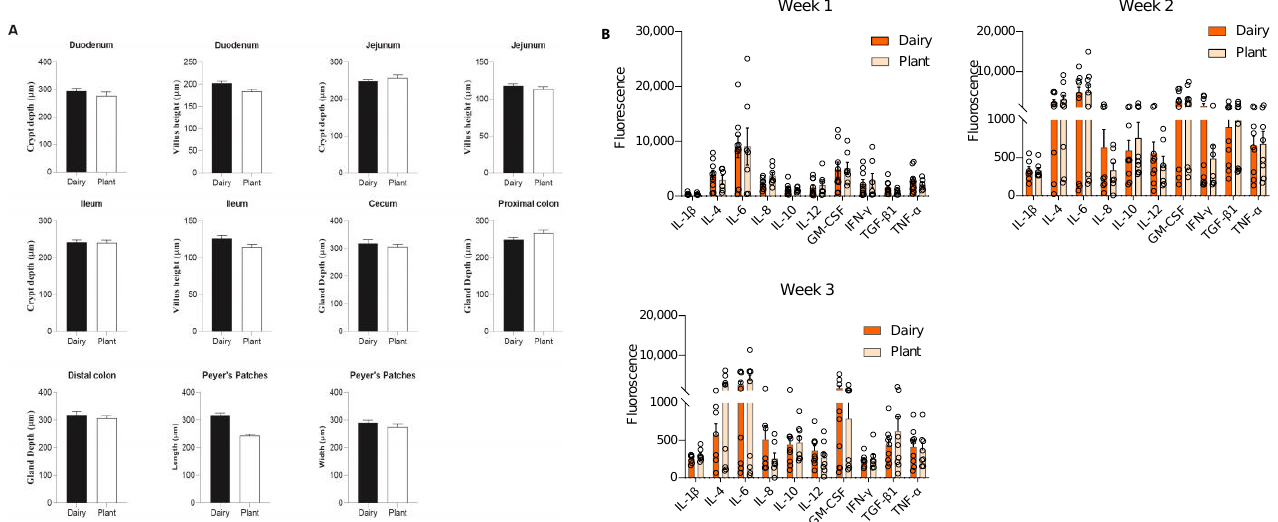
Figure 6. Histomorphometric analyses and plasma cytokines levels of piglets fed a dairy-based formula or a plant-based formula. ( A ) Histomorphometric parameters of duodenum, jejunum, ileum, cecum, colon, and Peyer’s patches. Histomorphometric parameters between formula treatments were compared using a repeated-measures linear mixed model with random intercepts for group and individual nested within group ( n = 10 spatially separated measurements per piglet and n = 9/group); ANOVA was performed using the Satterthwaite approximation for the denominator degrees of freedom. p < 0.05 was considered significant. ( B ) Plasma cytokine levels at 1, 2, and 3 weeks of age of the piglets fed either a dairy-based or a plant-based formula ( n = 9/group). Group differences were calculated using the Mann–Whitney test and p < 0.05 was considered significant.